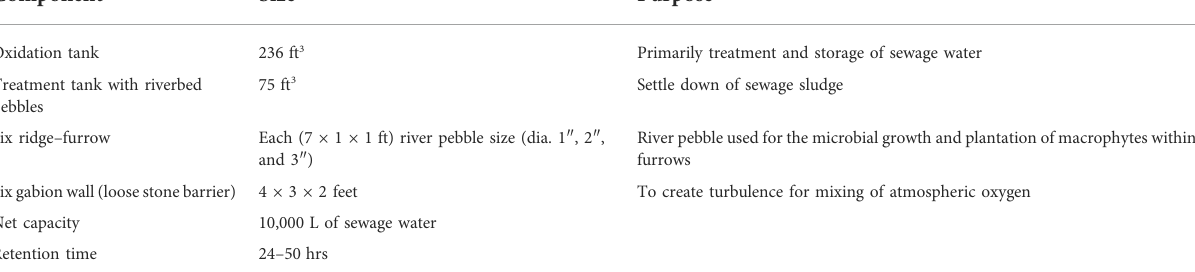
TABLE 2 Main characteristics and operation parameters of the CWS.